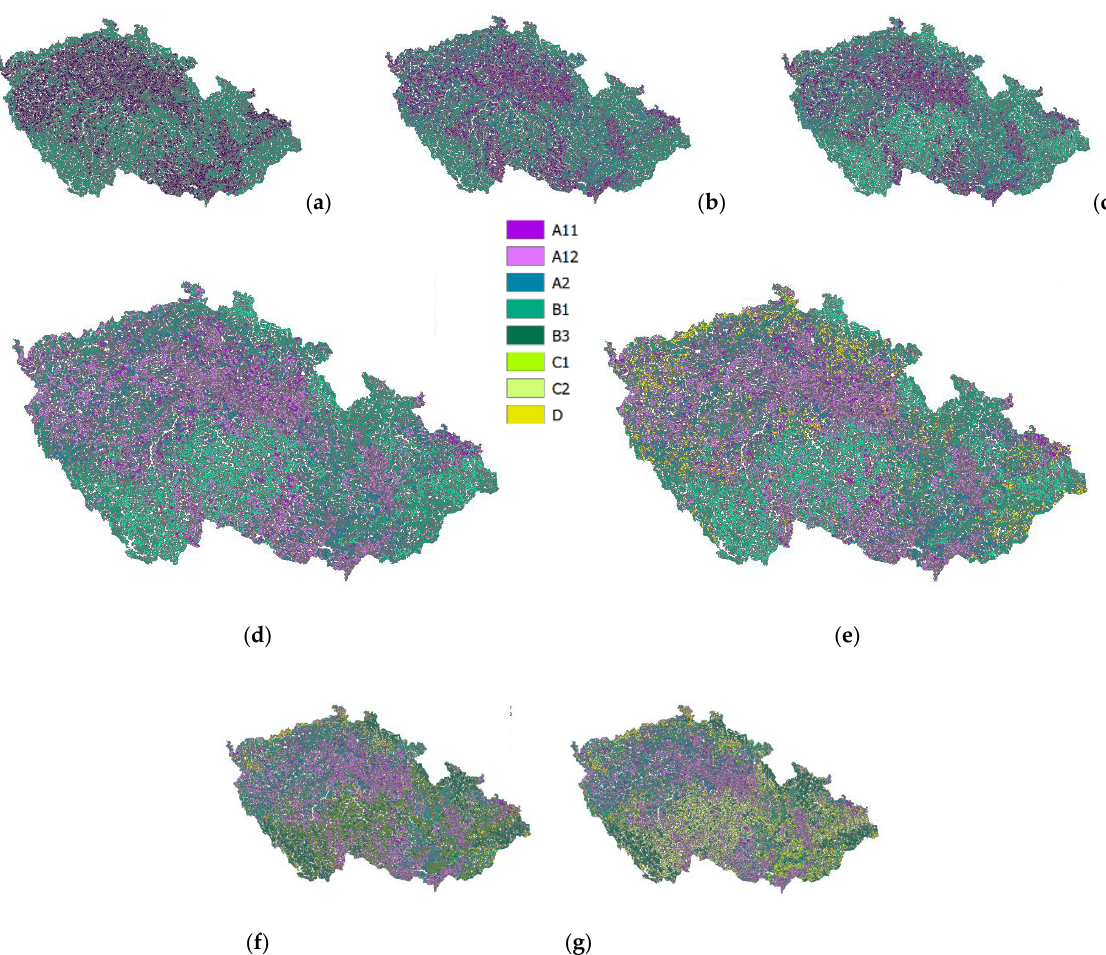
Figure 8. Geographical representation of the development of the groups during the formation of two to eight ( a – g ) clusters. The gradually generated groups of catchments are characterized by the mean values of the five selected parameters. The Davies-Bouldin index was used to determine the optimal number of clusters using Clustering Validity Indices (CVI) (Figure 9). The optimal number of clusters from this is five. A suitable number of clusters is six, from which completely new class D arises (described in more detail in